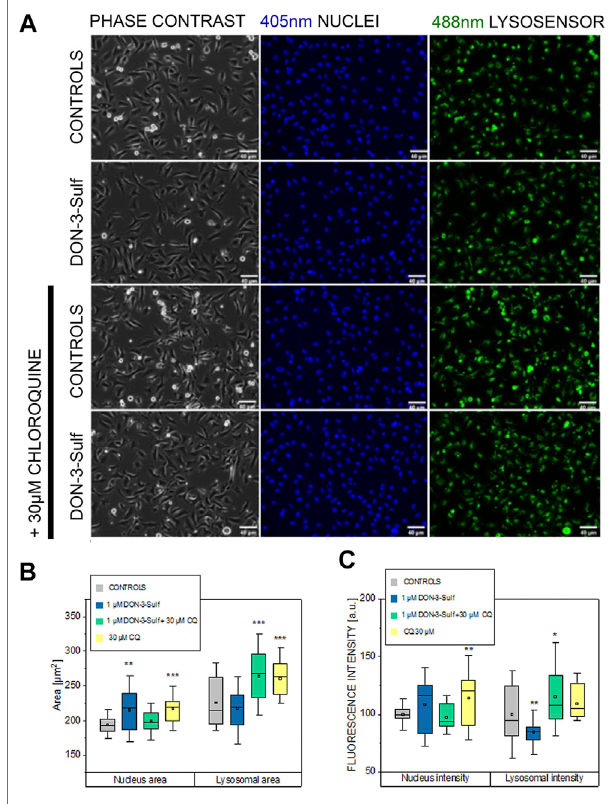
FIGURE 5 | Response of T24 to shear stress stimulation. (A) Phase contrast and fl uorescence images after staining with Hoechst (nuclei 405 nm, blue) and Lysosensor (lysosomes 488 nm, green) after incubation with 1 µM DON-3-Sulf and/or 30 µM chloroquine (CQ). (B) and (C) Image analysis of nuclear and lysosomes area and fl uorescence intensity (arbitrary units). Data are mean of n (cid:1) 24 randomly chosen fi elds of view imaged in the micro fl uidic channels. * indicates signi fi cant difference in comparison to controls at the Student ’ s t -test (*: p ≤ 0.05; **: p ≤ 0.01; ***: p ≤ 0.001; scale bar: 40